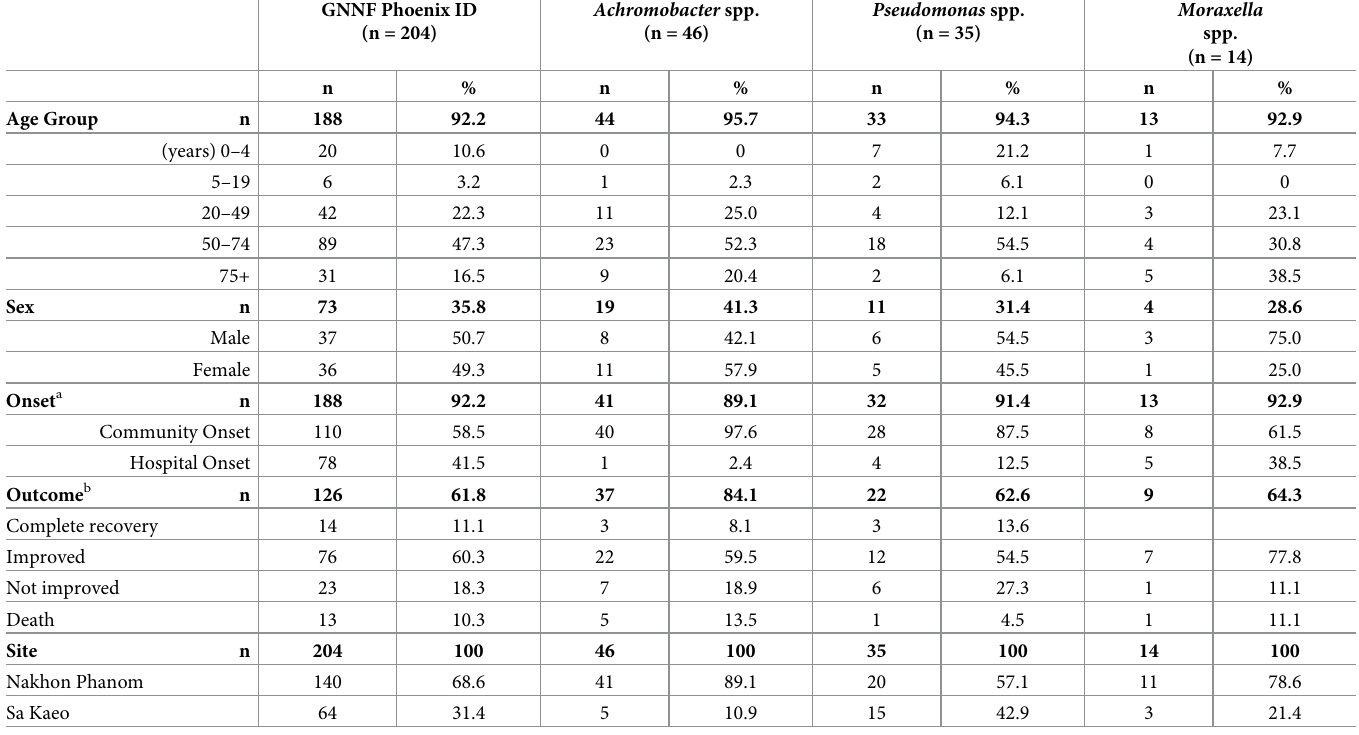
Table 1. Demographic data associated with the 204 unidentified isolates processed using the BD Phoenix automated identification system, focusing on commonly identified